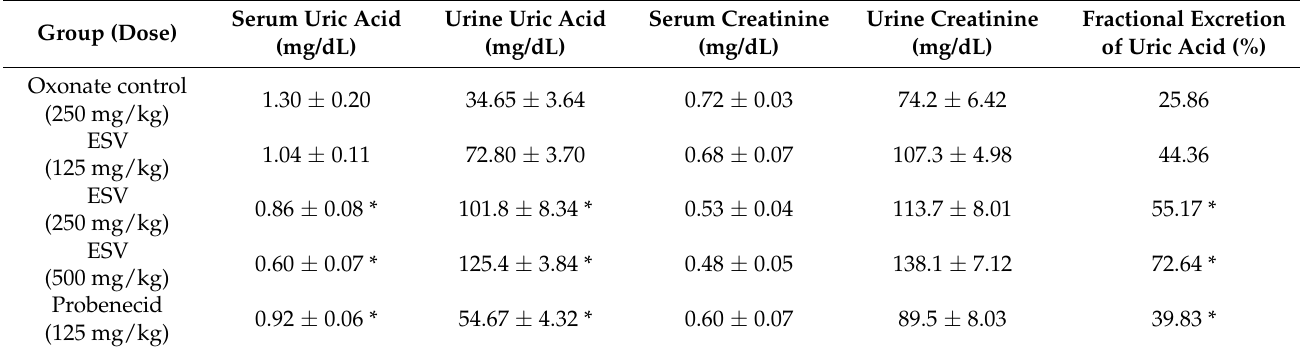
Table 1. Antihyperuricemic effect of the extract from S. virgaurea (ESV) in rats.